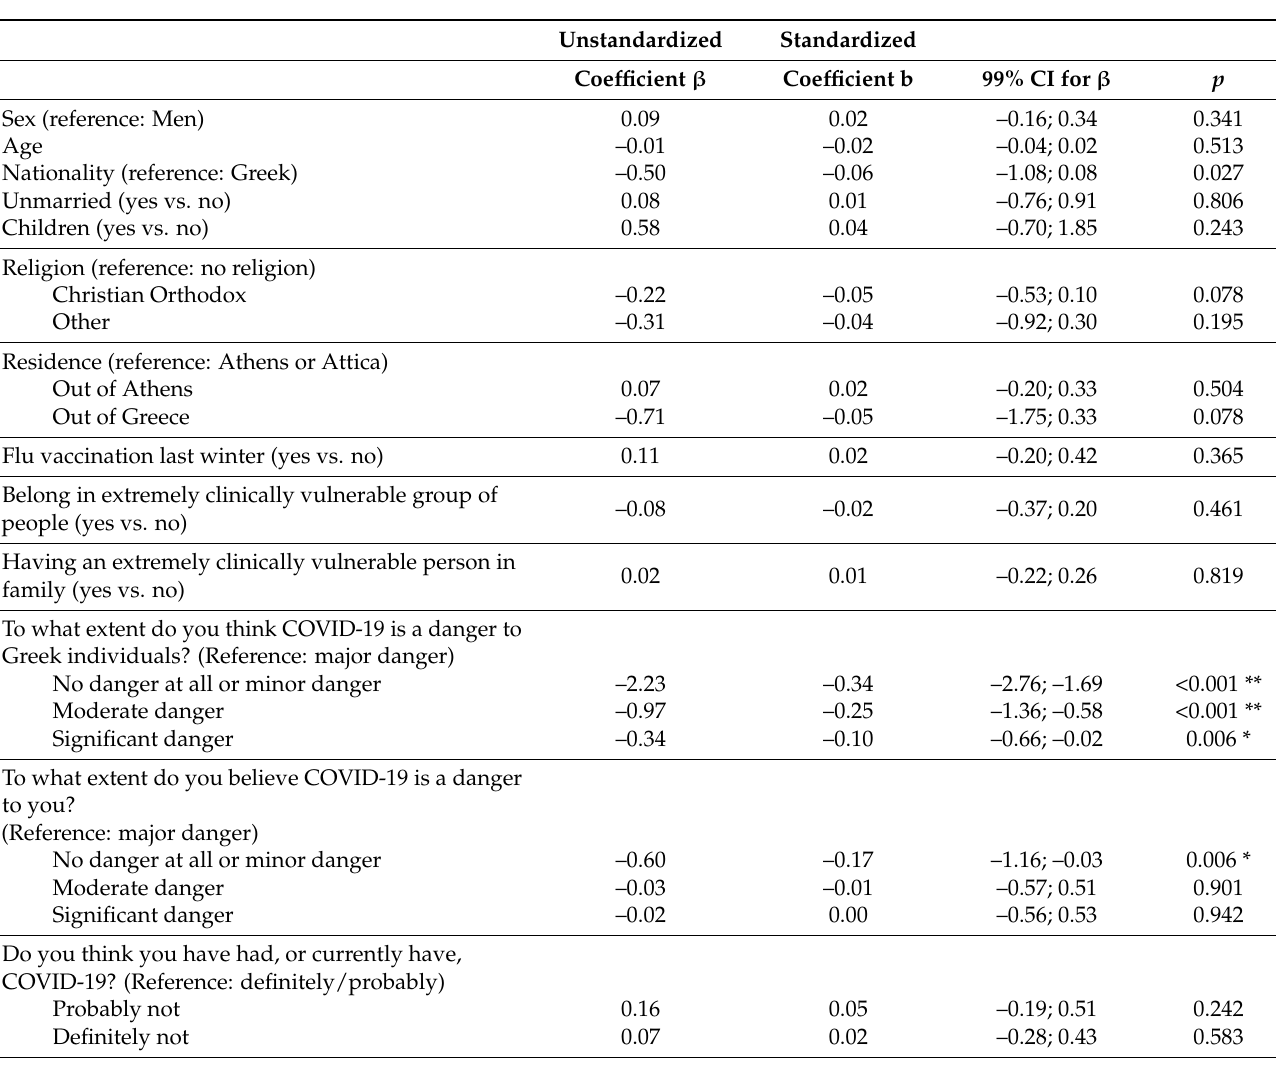
Table 4. Multiple linear regression analysis results having the number of behavioral changes due to COVID-19 pandemic as a dependent variable and students’ characteristics and their perceptions for COVID-19 pandemic as independent